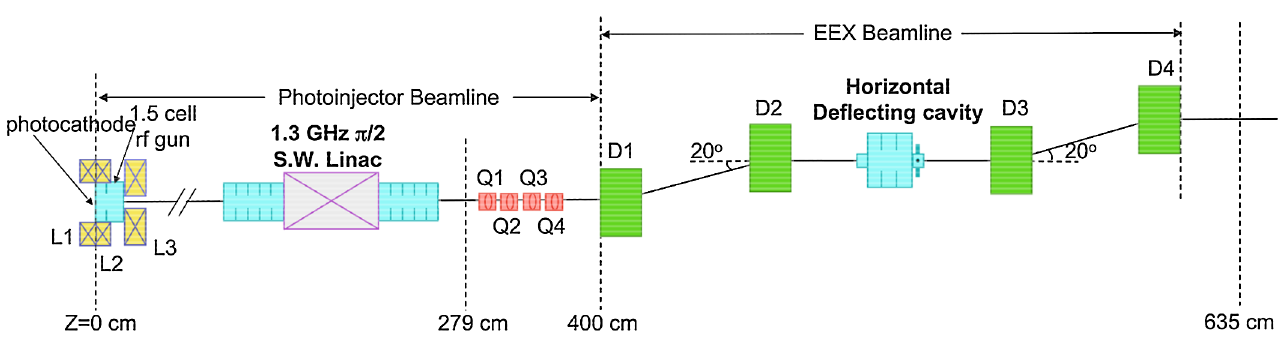
FIG. 10. Overview of the photoinjector configuration used for realistic simulations of bunch shaping. The legend is ‘‘ D i ’’ dipole magnets, ‘‘ Q i ’’ quadrupole magnets, ‘‘ L i ’’ solenoidal lenses. The geometry of the EEX beam line is detailed in Table